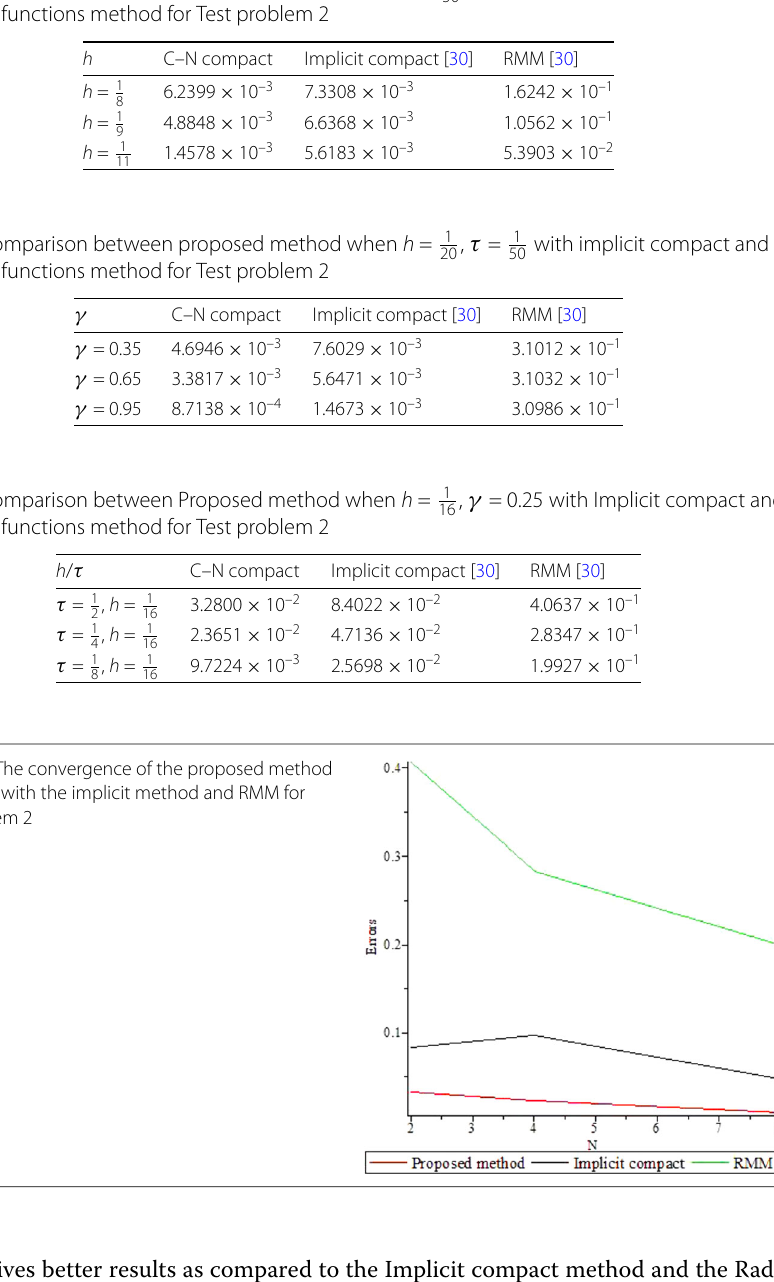
, γ = 0.25 with implicit compact and 50